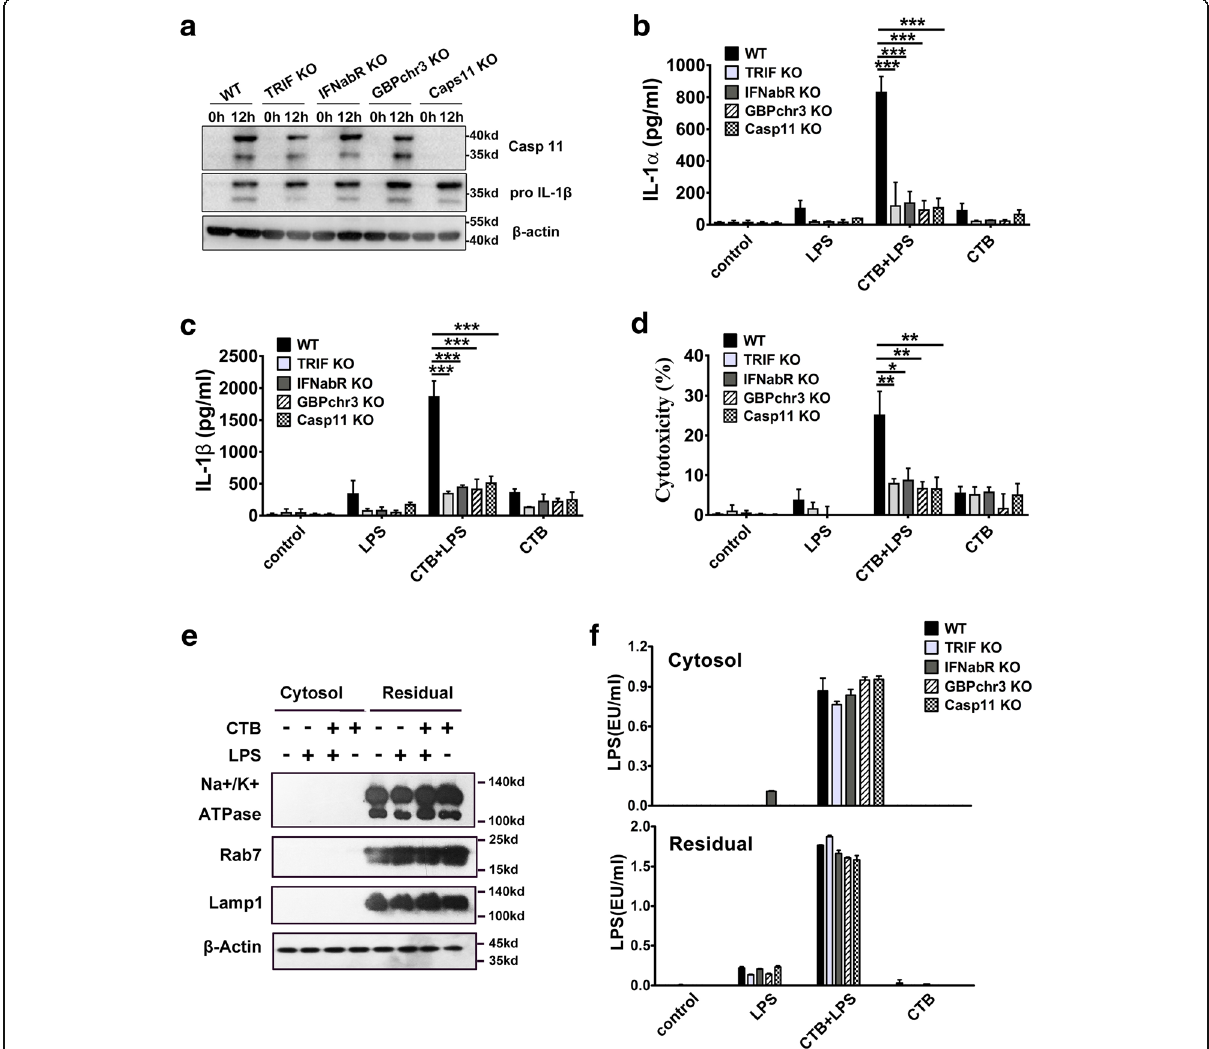
Fig. 7 TRIF-interferon-GBPs pathway is required for caspase-11 activation in vitro. a Western-blot to detect the expression of caspase-11, IL-1 β and β -Actin in splenocytes isolated from mice of indicated genotypes following intraperitoneal injection with either 10 mg/kg LPS or saline. b-d ELISA for IL-1 α , IL-1 β and LDH assay in the supernatants of peritoneal macrophages stimulated with either LPS (1 μ g/ml) alone or LPS (1 μ g/ml) plus CTB. Supernatants were collected 16 h after stimulation. e Western-blot for Na+/K+ ATPase, Rab7, LAMP1 and β -actin in the cytosolic and residual fractions from LPS (1 μ g/ml) or CTB plus LPS (1 μ g/ml) or CTB alone -stimulated mouse peritoneal macrophages obtained by digitonin fractionation. f LPS activity assay in the cytosolic and residual fractions from LPS (1 μ g/ml) or CTB plus LPS (1 μ g/ml) or CTB alone -stimulated mouse peritoneal macrophages obtained by digitonin fractionation. * P <0.05; ** P <0.01; *** P <0.001 (Student ’ s t-test). Graphs show the mean ±